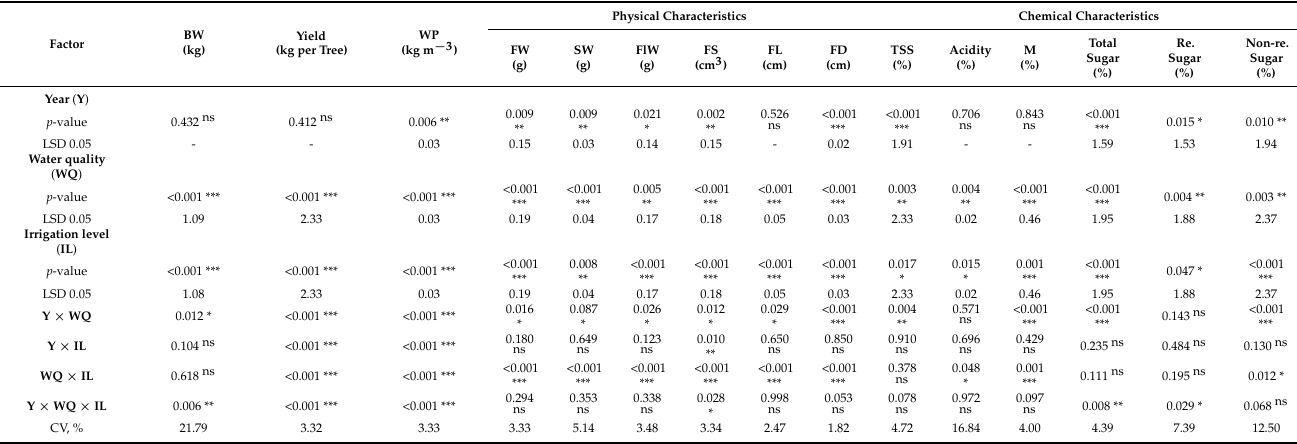
Table 3. Statistical analysis of the effects of water quality and irrigation level on the bunch weight (BW), yield, water productivity (WP) of date palms, and physical and chemical characteristics of dates during the experimental years. PhysicalCharacteristics ChemicalCharacteristics